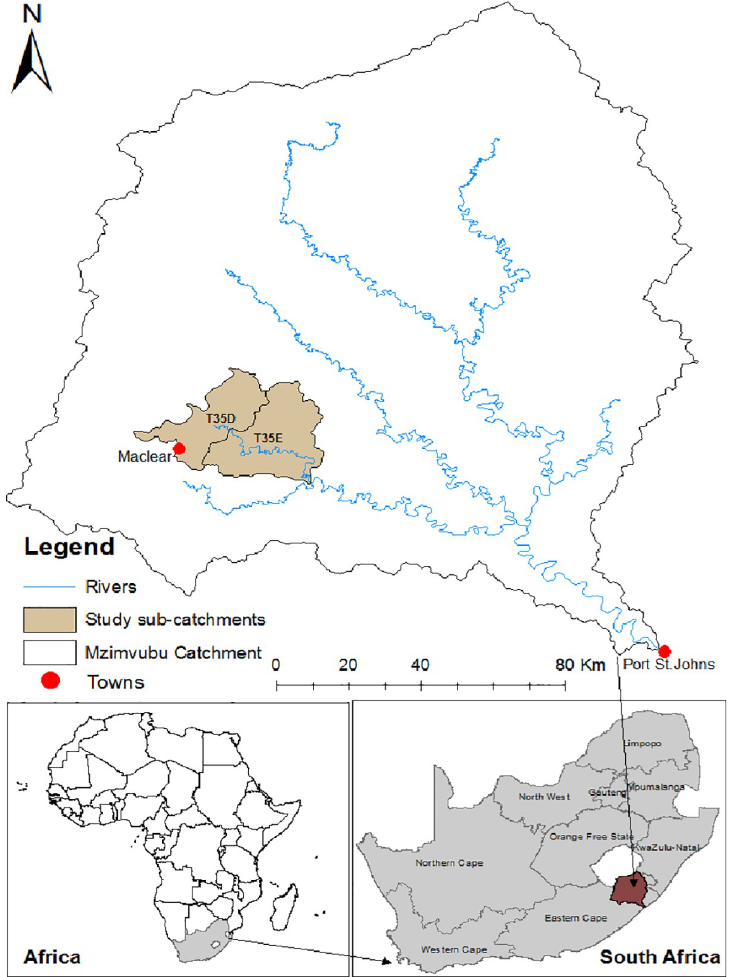
Fig 1. Locality map of quaternary catchments T35D and T35E in the Tsitsa River catchment within the Mzimvubu catchment, Eastern Cape, South Africa.